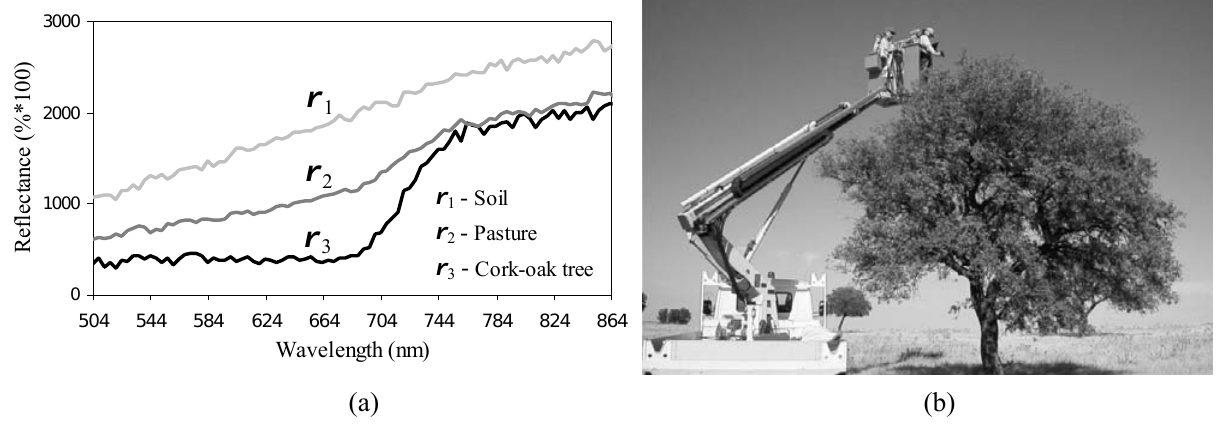
Figure 2. (a) ROSIS spectral signatures of soil ( Ground-truth data collection over a semi-arid test site using an ASD FieldSpec Pro spectro-radiometer.